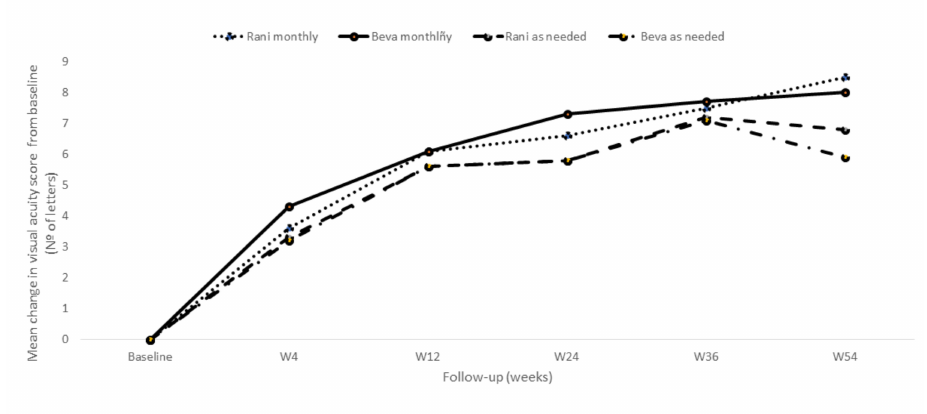
Figure 2. Mean change in the visual-acuity score during the first year of follow-up observed in the CATT study. Adapted from CATT Research Group et al. [100]. Rani: Ranibizumab; Beva: